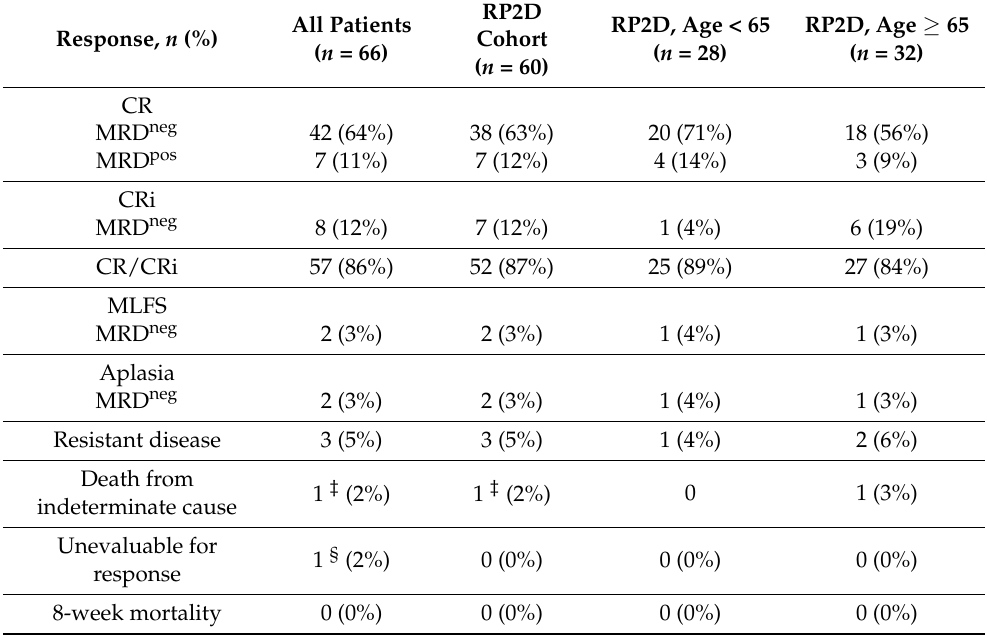
Table 3. Best response after 1–2 cycles of study therapy.